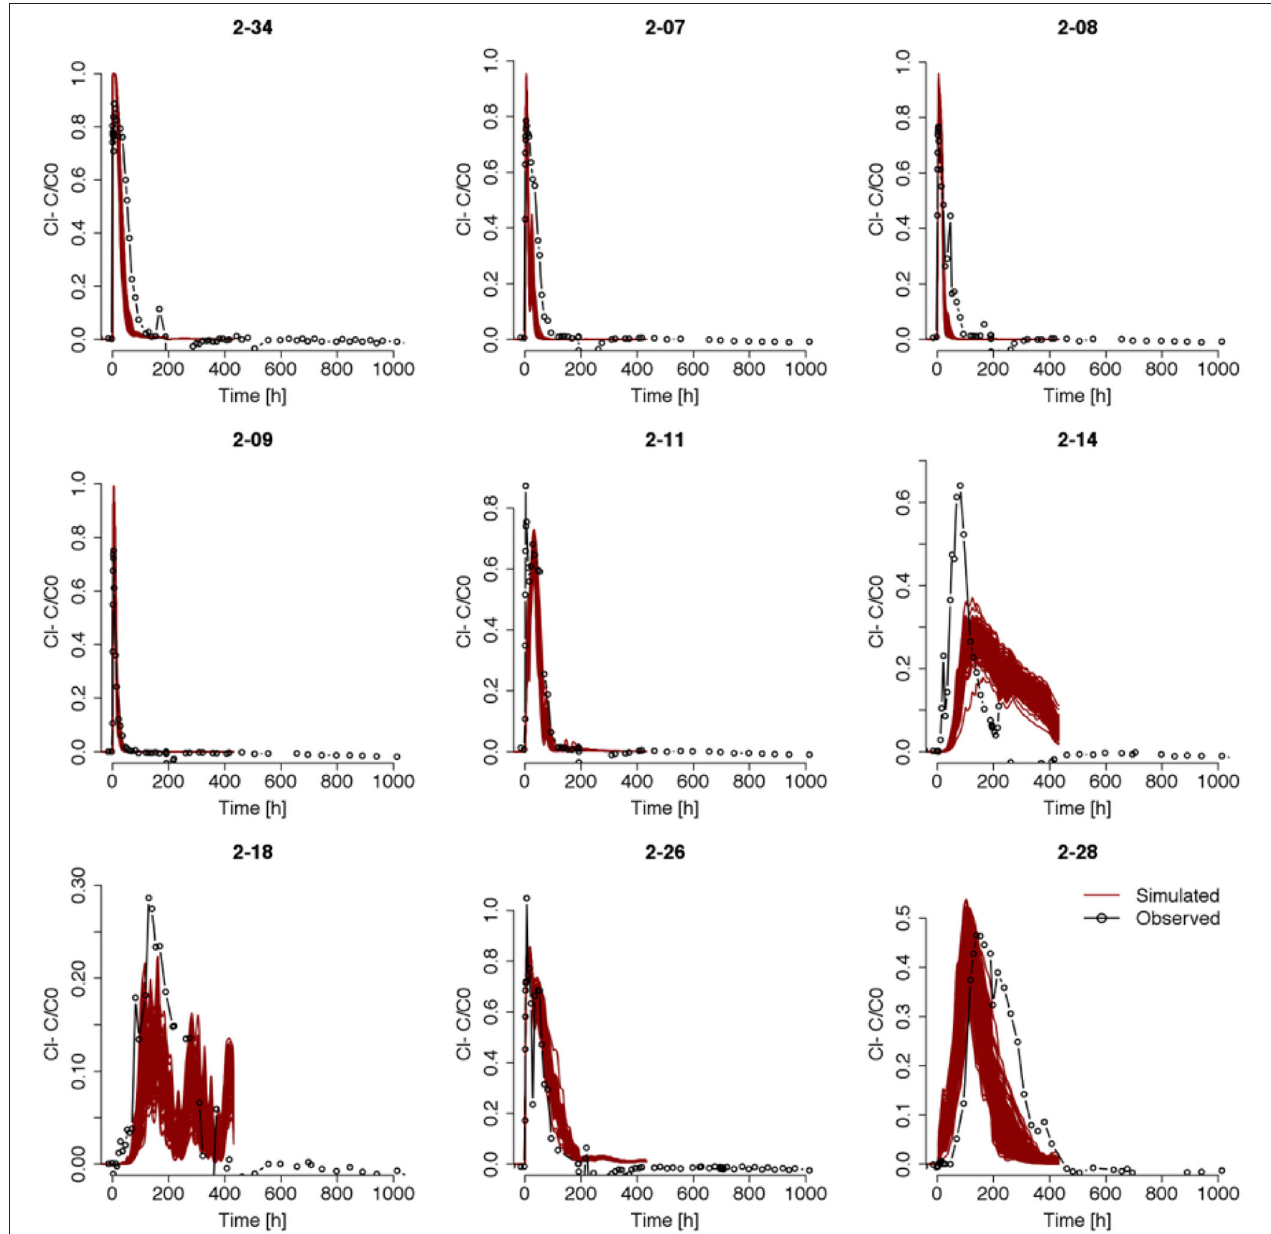
FIGURE 5 | Ensemble of predicted tracer breakthrough curves during Test 1 in selected wells using permeability field estimations from previous data assimilation work (Chen et al., 2013). The connected dots are observed breakthrough curves and each line is a realization from the ensemble of predicted breakthrough curves. The well name for each plot is given in the title for each plot. The ensemble size is